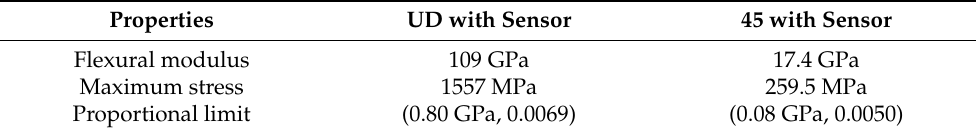
Table 2. Mechanical properties of UD and angle-ply CFRP specimens with